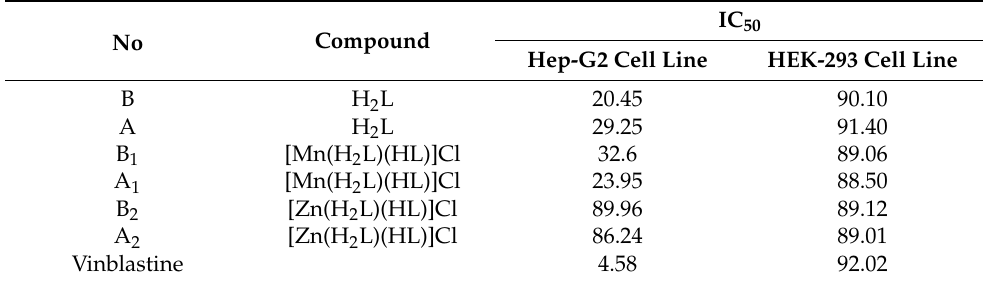
Table 9. Cytotoxic activity (IC 50 ) of the ligand and some metal complexes against human liver Hep-G2 and HEK-293 cell lines compared to